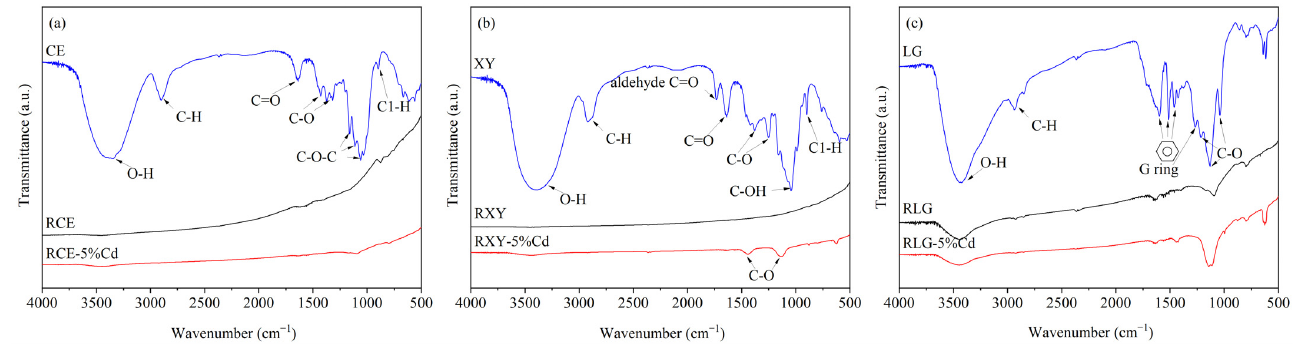
Figure 4. FTIR spectrums of three model components and their pyrolysis residue. ( a ) CE, RCE, and RCE-5%Cd; ( b ) XY, RXY, and RXY-5%Cd; ( c ) LG, RLG, and RLG-5%Cd. RCE, RXY, and RLG represent the pyrolysis residue of cellulose, xylan, and lignin, respectively. RCE-5%Cd, RXY-5%Cd, and RLG-5%Cd represent the pyrolysis residue of Cd-concentrated cellulose, xylan, and lignin, respectively.